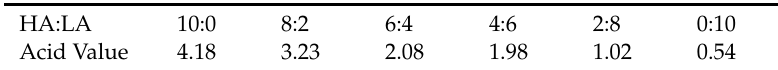
Table 2. The acid values of blends of high- and low-acid-value waste cooking oils at different mixing